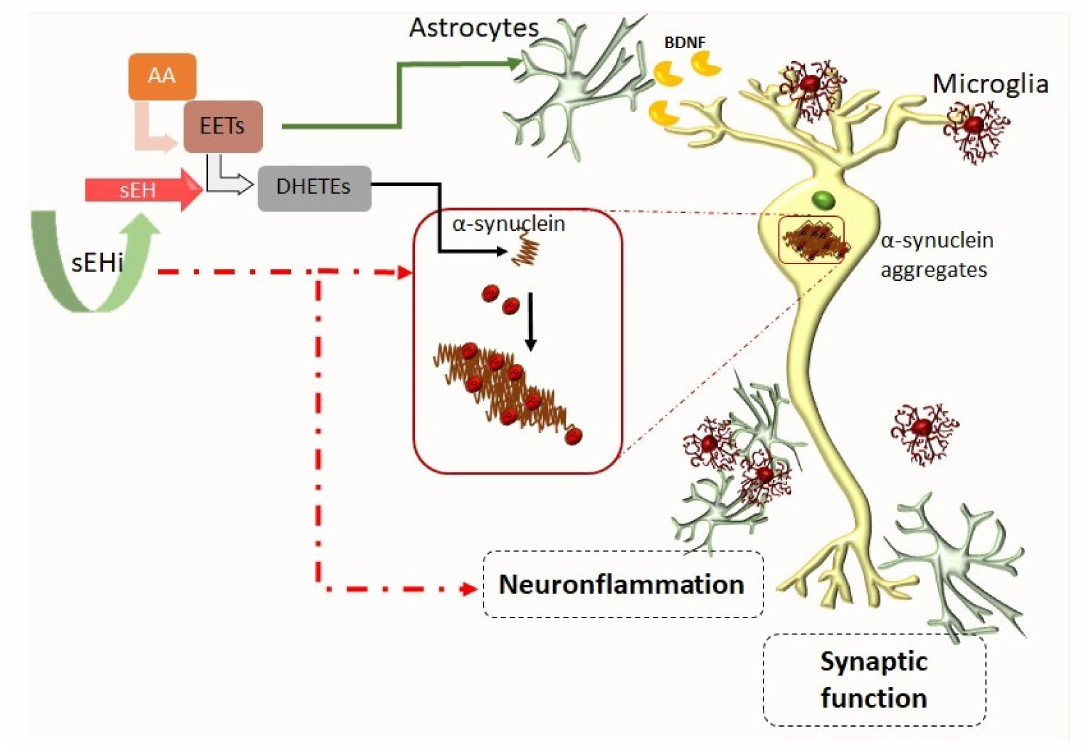
Figure 2. Crosstalk between glial cells, neuroinflammation process, synaptic function, and phosphorylation of α -synuclein favoring aggregation described in PD models [111]. Dotted red line and green line indicate putative regulation role for